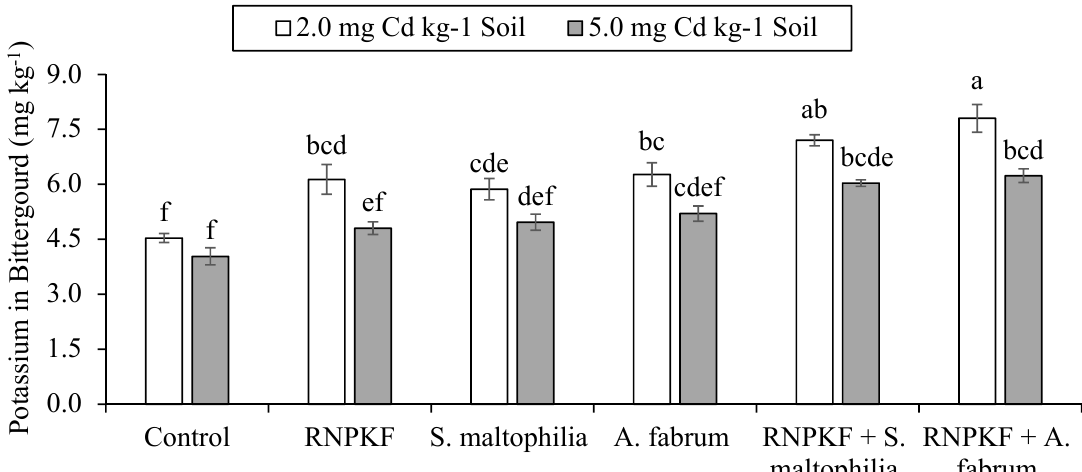
Figure 14. Potassium concentration in bitter gourd (%) treated with PGPRs, RNPKF, and their combination under 2 and 5 mg Cd kg − 1 soil. Different small letters express significant differences ( p ≤ 0.05).